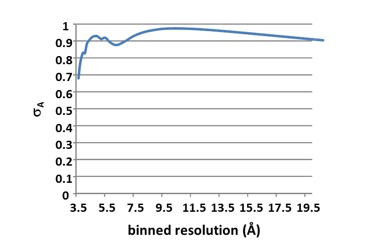
DOI:
http://dx.doi.org/10.7554/eLife.20383.020